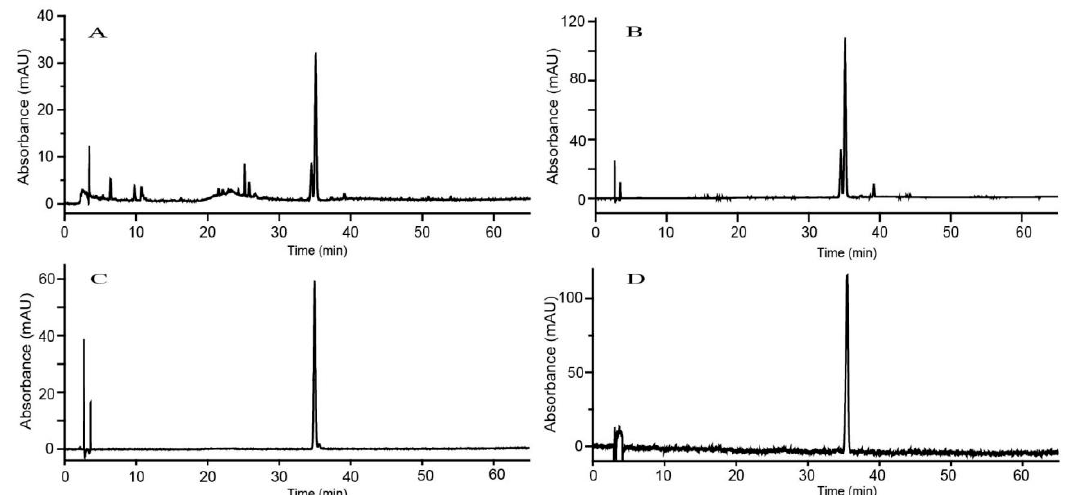
Figure 3. HPLC chromatograms of the TFC extracts before ( A ) and after ( B ) D-101 resin enrichment. HPLC chromatogram of purified linarin ( C ) and pectolinarin ( D ) detected at 330 nm.